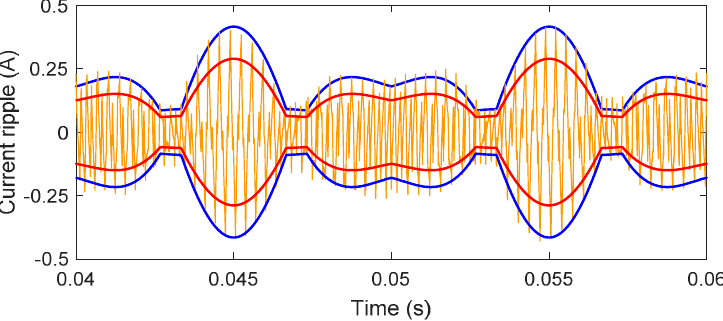
Figure 8. Measured current ripple (orange trace) and calculated current ripple envelopes (blue trace: L eq measured at f sw = 3 kHz, red trace: L eq measured at 50 Hz).